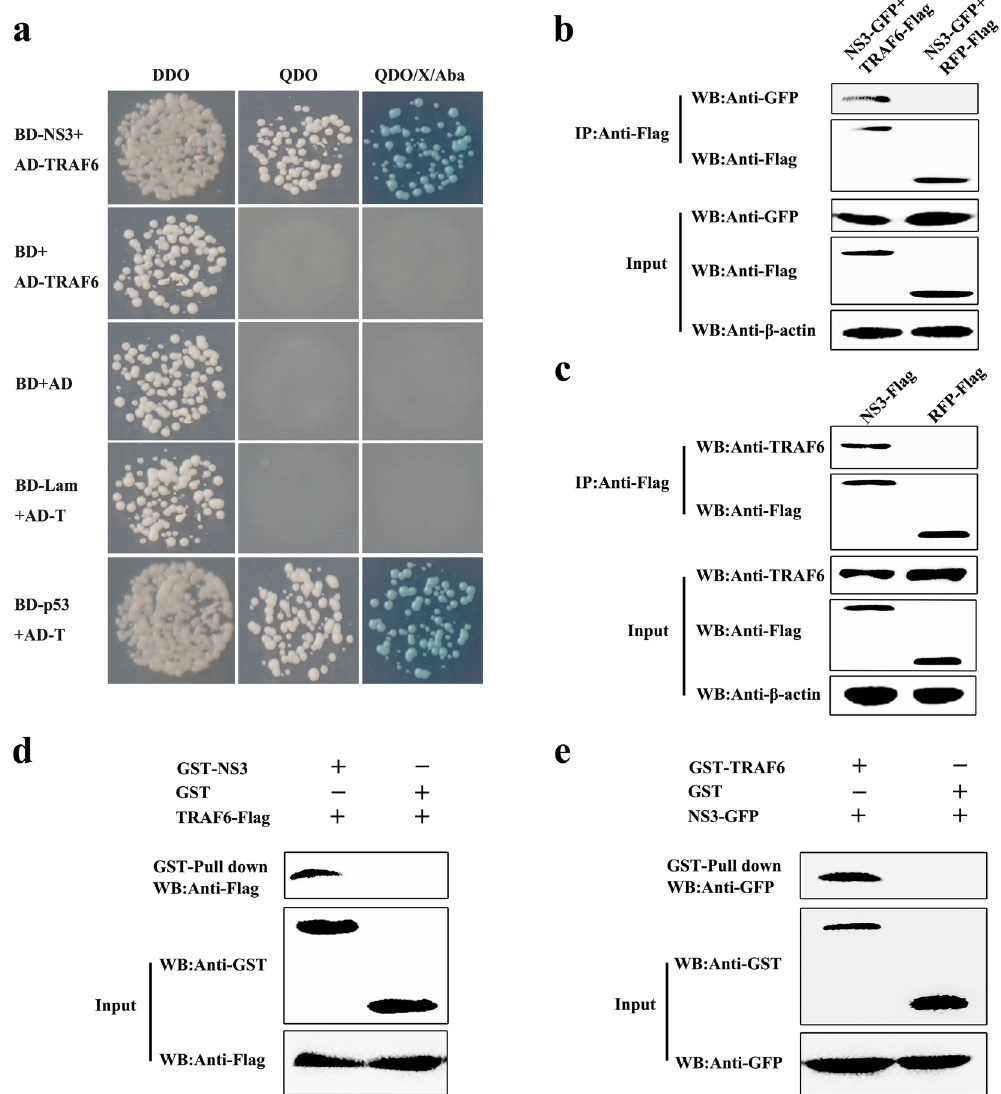
Figure 1. Interaction of NS3 with TRAF6. ( a ) Interaction of NS3 with TRAF6 in a yeast two-hybrid system. The yeast strain Y2HGold was cotransformed with the prey plasmid AD-TRAF6 and the bait plasmid BD or BD-NS3. Cotransformation with BD/AD, BD-Lamin/AD-T, and BD-p53/AD-T were used as a blank, negative and positive controls, respectively. ( b ) Exogenous co-IP analysis of NS3 and TRAF6 in PAMs. Cells were co- transfected with plasmids NS3-GFP and TRAF6-Flag. PAMs co-transfected with NS3-GFP and RFP-Flag were used as negative controls. A quarter of the cell extract was subjected to the input assay to assess β -actin, Flag- fusion, and GFP-fusion protein levels. The rest of the extract was subjected to IP assay. Western blot detected proteins with a mouse anti-GFP mAb and a rabbit anti-Flag pAb. ( c ) Endogenous co-IP analysis of NS3 and TRAF6 in PAMs. Cells were transfected with plasmid NS3-Flag, and RFP-Flag-transfected PAMs were used as negative controls. The input assay was performed using a quarter of the cell extract to assess β -actin, Flag fusion protein, and TRAF6 levels. The precipitated proteins were detected with a rabbit anti-TRAF6 pAb and a rabbit anti-Flag pAb. ( d ) GST-NS3 pull-down assay. The GST and GST-NS3 proteins expressed in Escherichia coli Rosetta (DE3) cells were immobilized on a glutathione agarose resin, followed by incubation of the resin with the cell lysates containing TRAF6-Flag protein. After washing, the bound proteins were detected by Western blot using a mouse anti-Flag mAb. The expression of input proteins (TRAF6-Flag, GST or GST-NS3) was confirmed by Western blot using a mouse anti-Flag mAb and a mouse anti-GST mAb, respectively. ( e ) GST-TRAF6 pull-down assay. The GST and GST-TRAF6 proteins expressed in Escherichia coli Rosetta (DE3) cells were immobilized on the glutathione-agarose resin. The resin conjugated with GST or GST-TRAF6 was incubated with the cell lysates containing NS3-GFP protein. After washing, the eluted proteins were detected by Western blot using a mouse anti-GFP